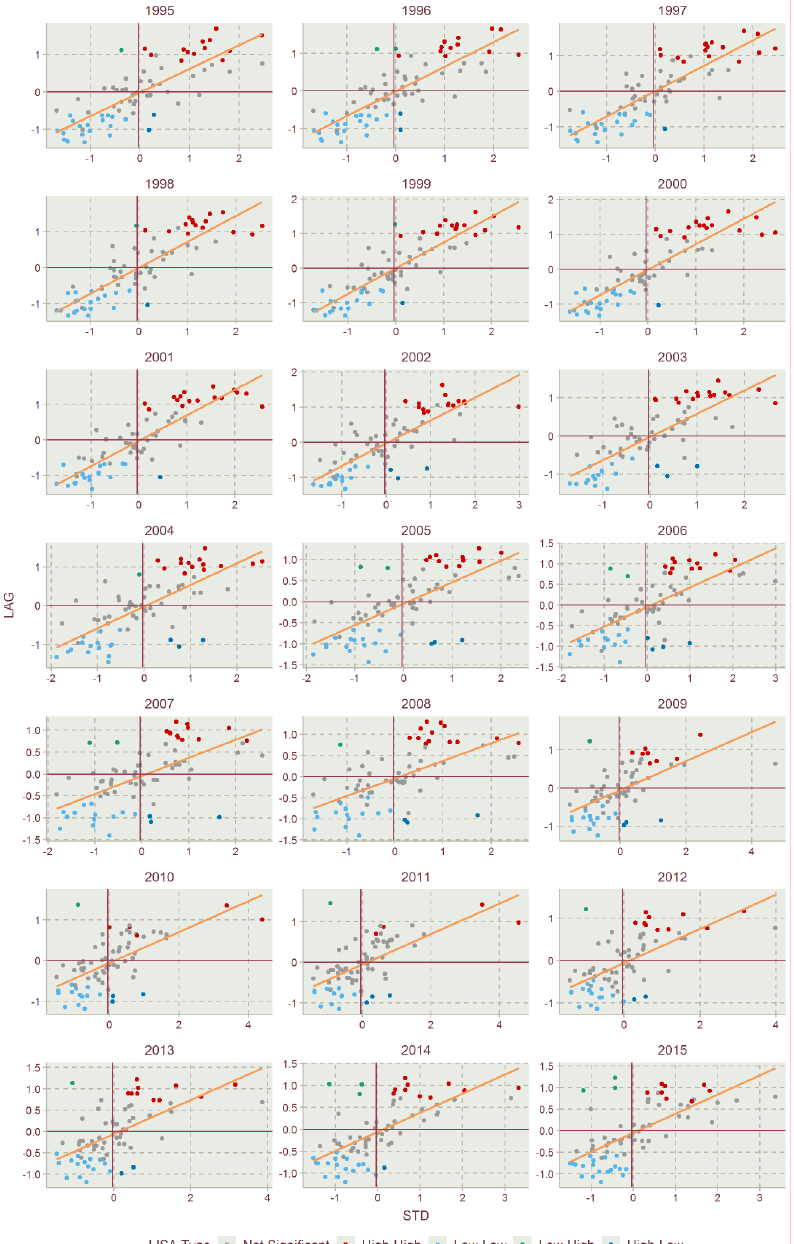
Figure 11. Moran’s scatter plots of EFIs of Jiangsu Province in 1995 – 2015.